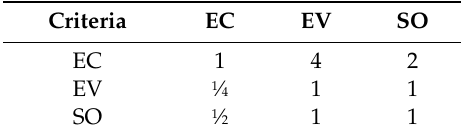
Table 5. Real number